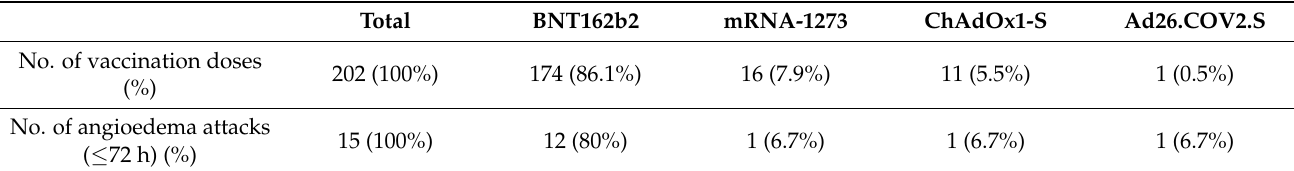
Table 4. No. and type of intramuscularly delivered vaccines as first doses and no. of angioedema attacks following the vaccination ( ≤ 72